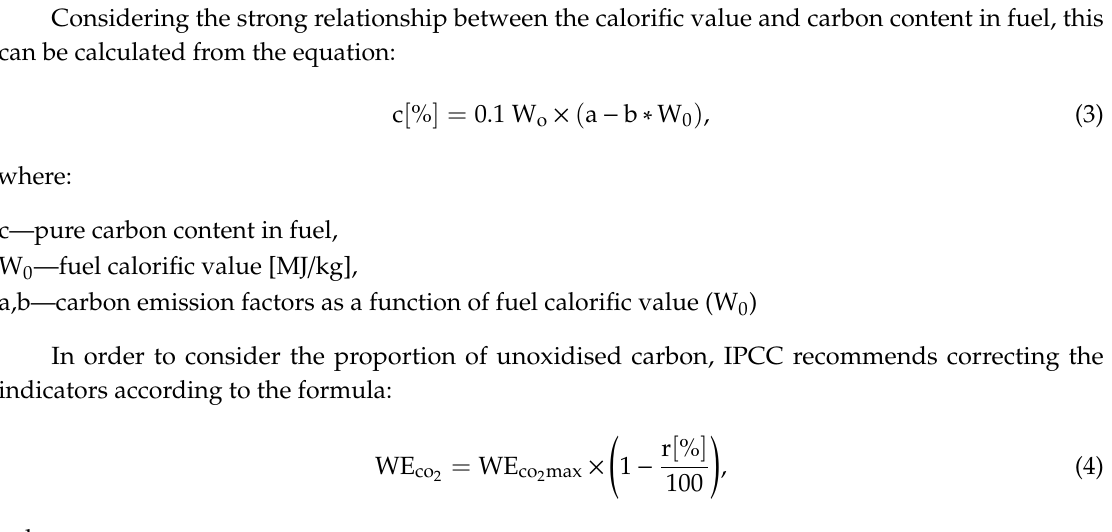
Figure 3. Algorithm of the procedure for the model’s energy module.